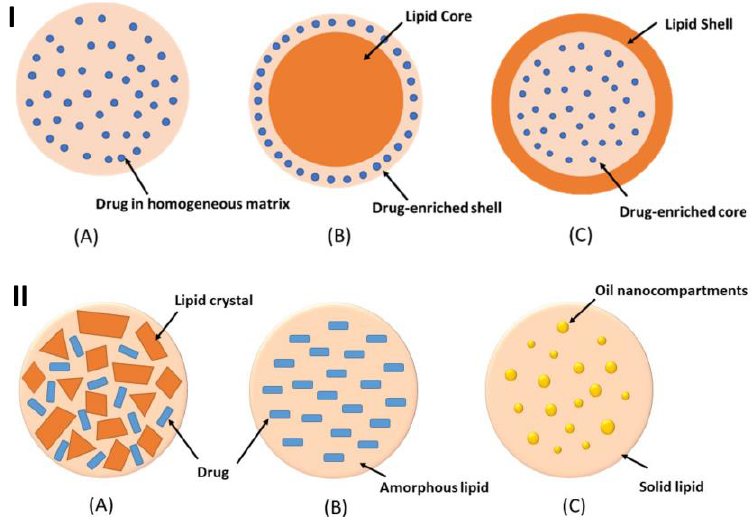
Figure 1. The active compounds or drug incorporation models of SLNs ( I ): homogeneous matrix ( A ), drug-enriched shell ( B ), and drug-enriched core ( C ); and NLCs ( II ): imperfect crystal type ( A ), amorphous type ( B ), and multiple-oil-in-fat-in-water type ( C ) [66]. Generally, the components in the formulation of NLCs consist of solid lipids, liq- uid lipids, surfactants, and cosurfactants. Commonly used solid lipids include glyceryl monostearate, glyceryl behenate, cetyl alcohol, and stearic acid [64,67]. Liquid lipids that can be used include isopropyl myristate and oleic acid. Commonly used surfactants are polysorbate 80 and poloxamer 188. Commonly used cosurfactants are ethanol, propylene glycol, glycerin, and sucrose stearate [68,69]. NLCs are formulated by forming a solid